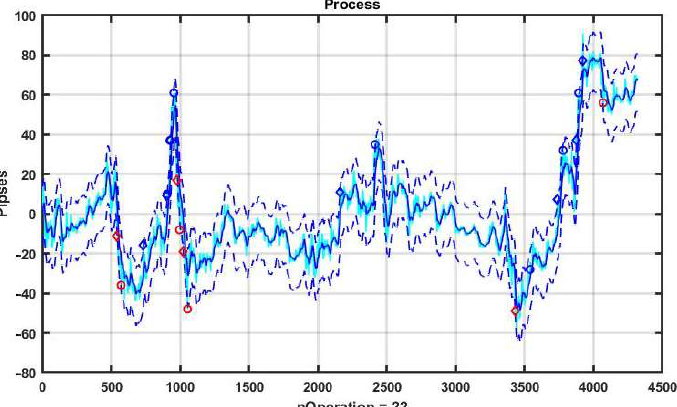
Figure 8. Example CSF implementation with three optimized parameters.